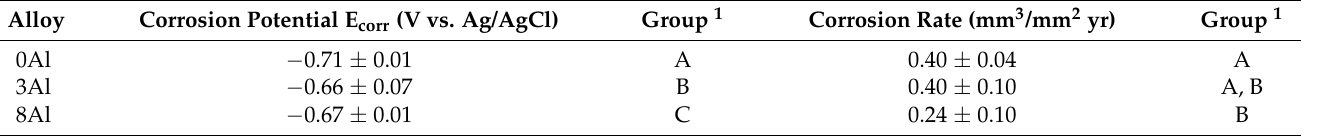
Figure 12. Polarization curves for the alloys corresponding to C w tests. Table 8. Corrosion potentials values (compared to the Ag/AgCl reference electrode) and corrosion rates of the